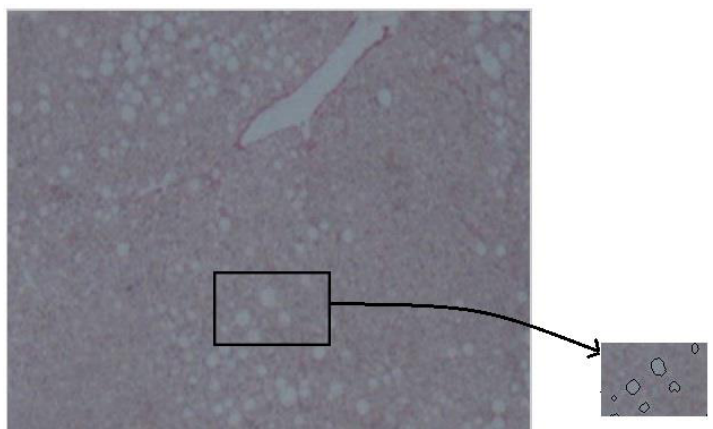
Figure 1. Liver biopsy image and annotated fat regions.